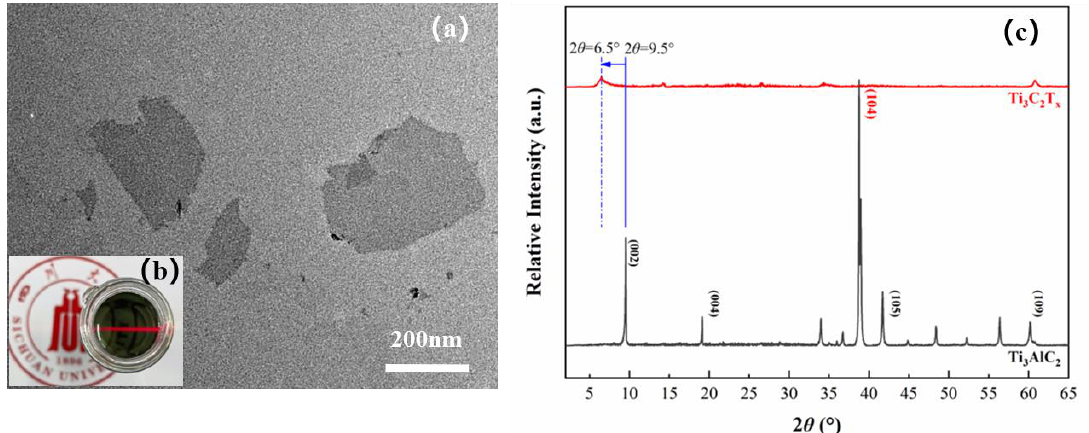
Figure 3. Analysis of Ti 3 C 2 T x ( a ) TEM image of Ti 3 C 2 T x dispersed in distilled water; ( b ) Digital photo of diluted Ti 3 C 2 T x dispersion in distilled water under a red laser beam; ( c ) XRD pattern of Ti 3 AlC 2 and Ti 3 C 2 T x .